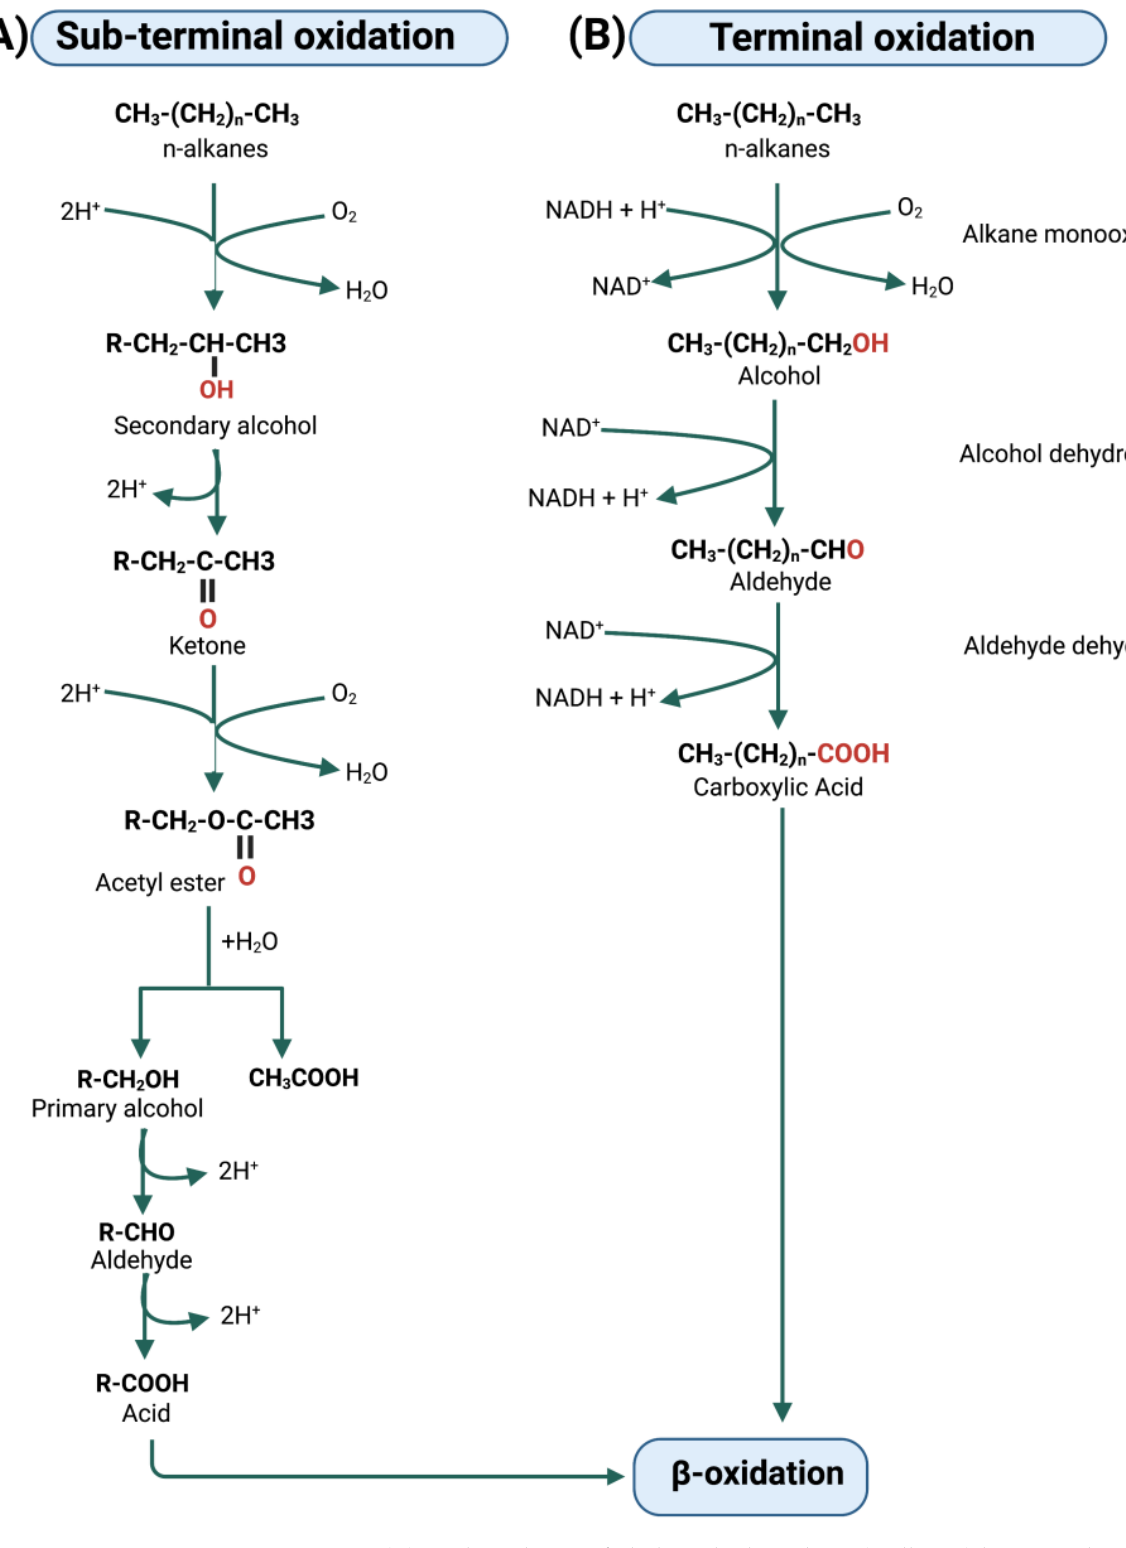
Figure 3. ( A ) Biodegradation of aliphatic hydrocarbons (n-alkanes) by an oxidation of the sub- terminal methyl group and ( B ) of the terminal methyl group.